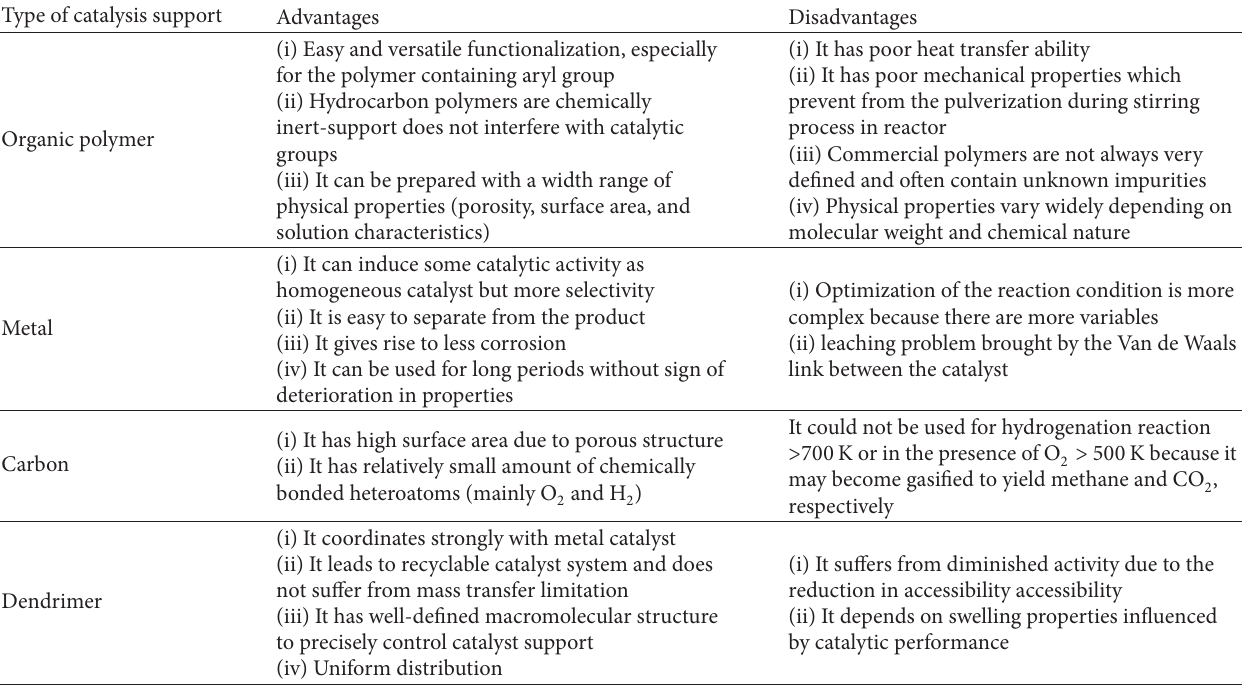
Table 1: List of advantages and disadvantages of heterogeneous catalysis